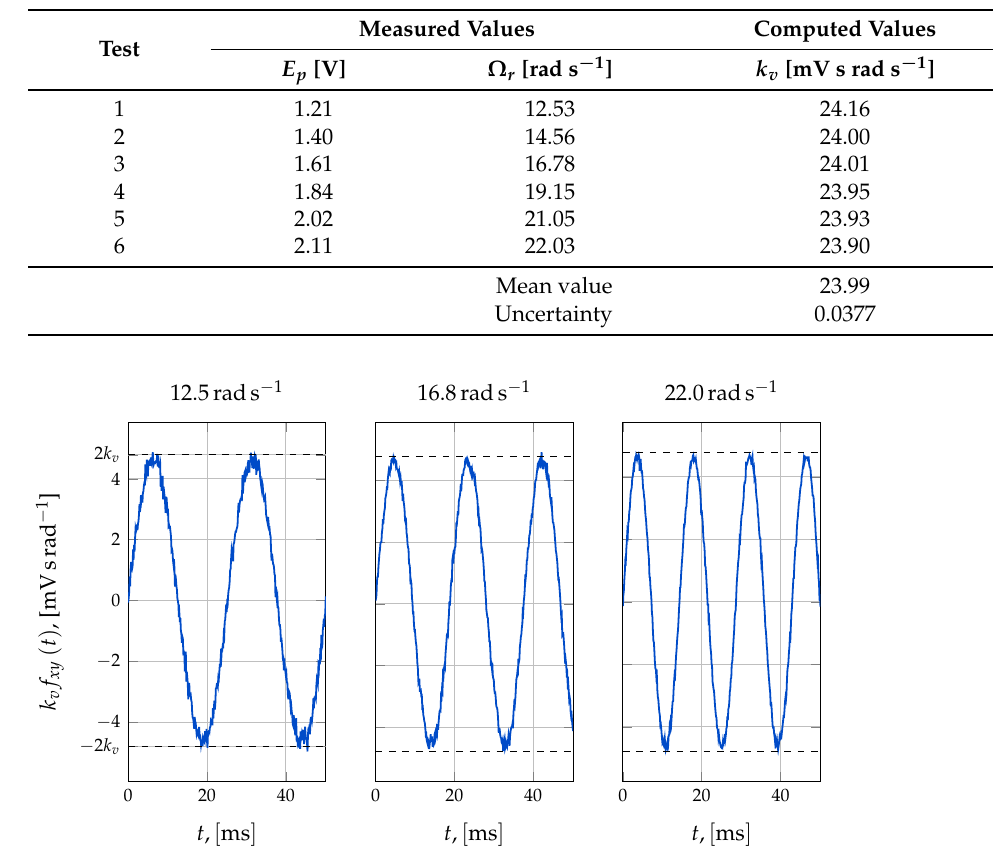
Figure 5. Shape functions of back-emf force for different rotor speeds. The dashed lines indicate the amplitude 2 k v